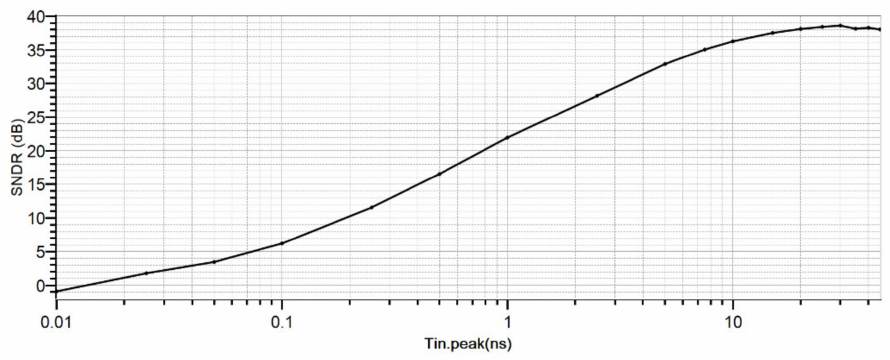
Figure 15. SNDR as function of T in.peak for 50 KHz.